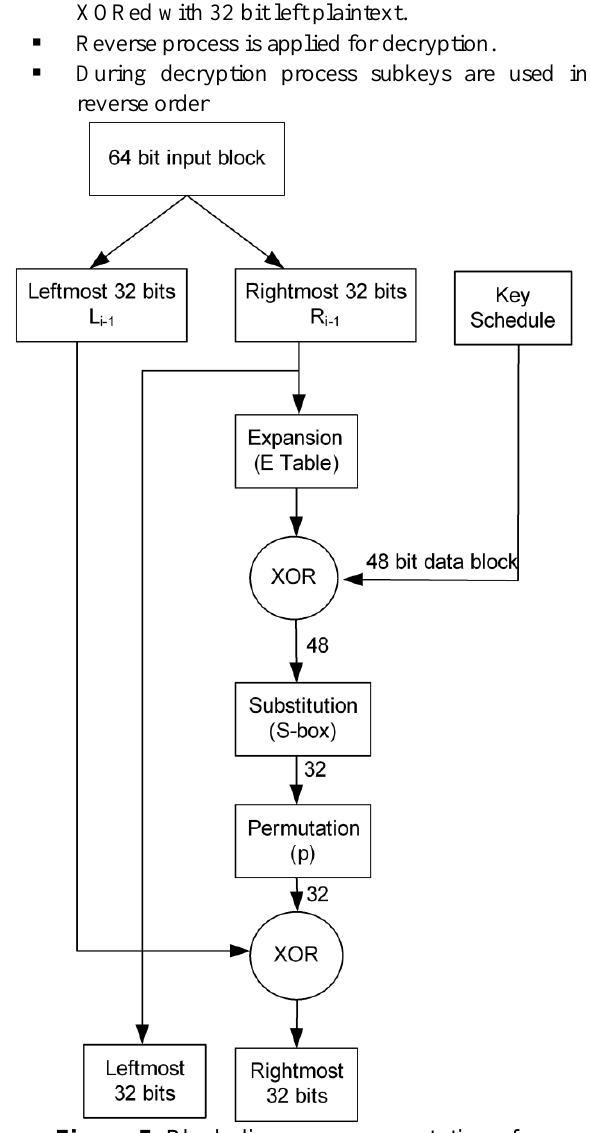
Figure 5 . Block diagram representation